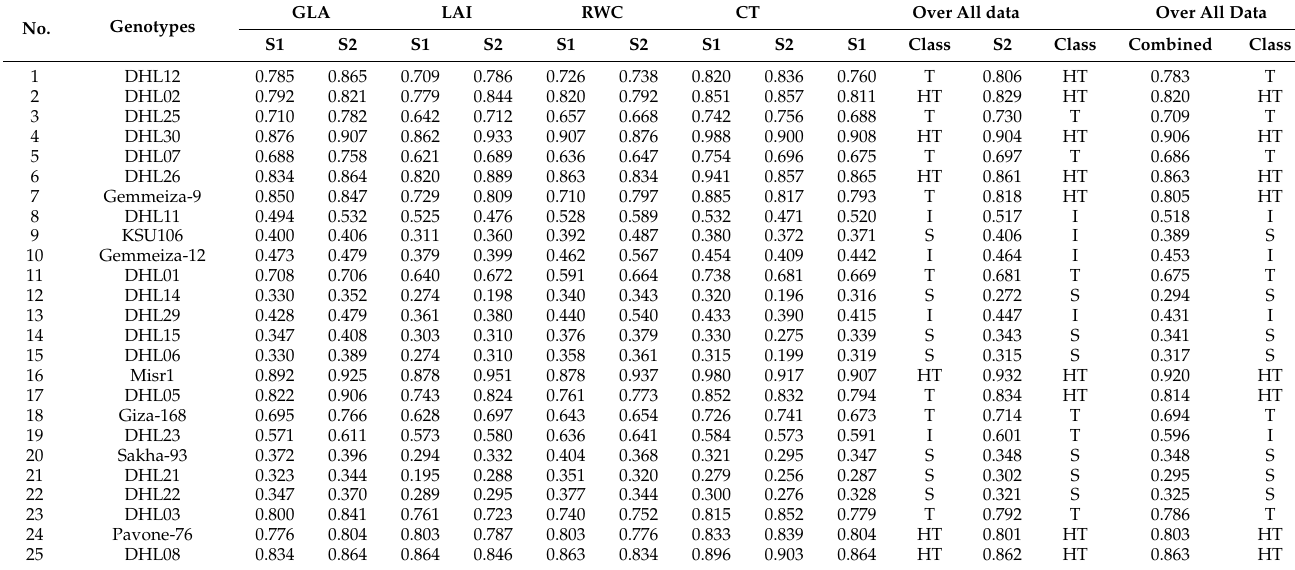
Table 6. Membership index score for the 25 wheat genotypes based on four selected traits (green leaf area, leaf area index, relative water content and canopy